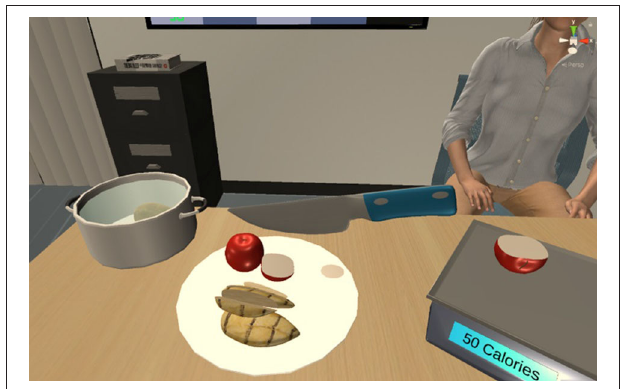
FIGURE 3 | Cutting food items with the virtual knife to meet a set calorie goal (interactive condition).